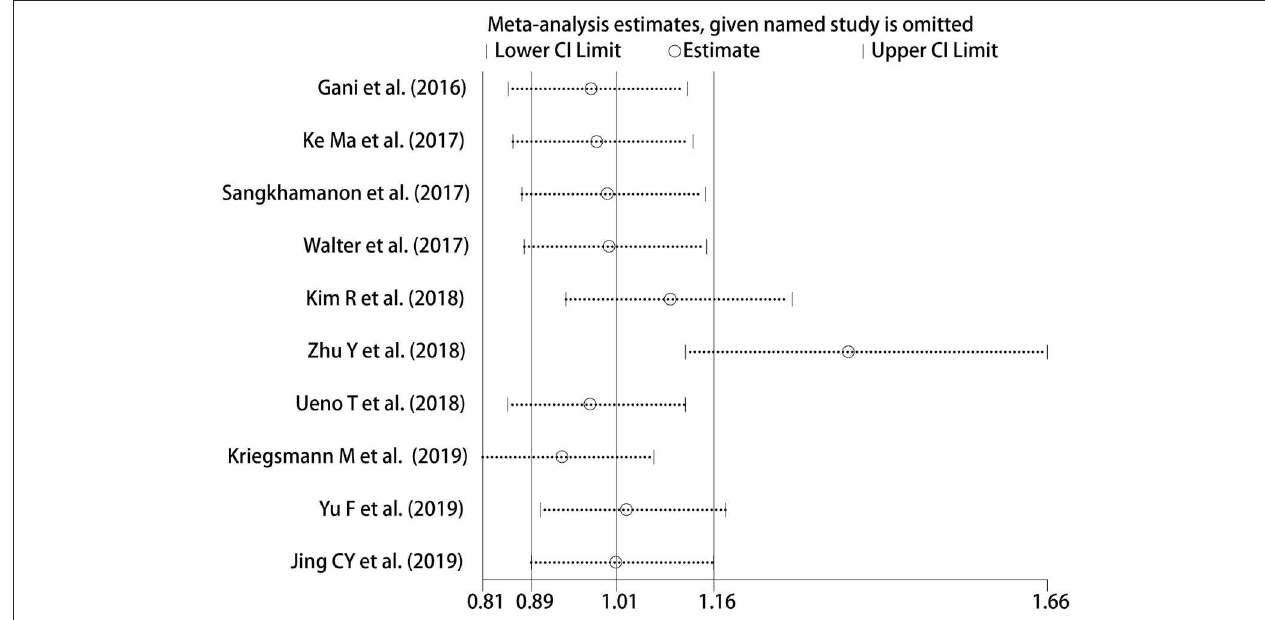
FIGURE 7 | Sensitivity analysis between PD-L1 expression in TCs and